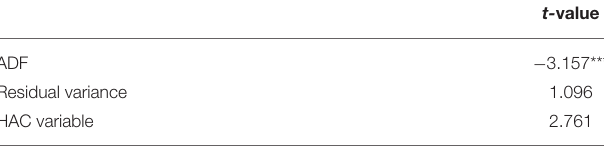
TABLE 7 | Panel cointegration test (POU) of Kao.